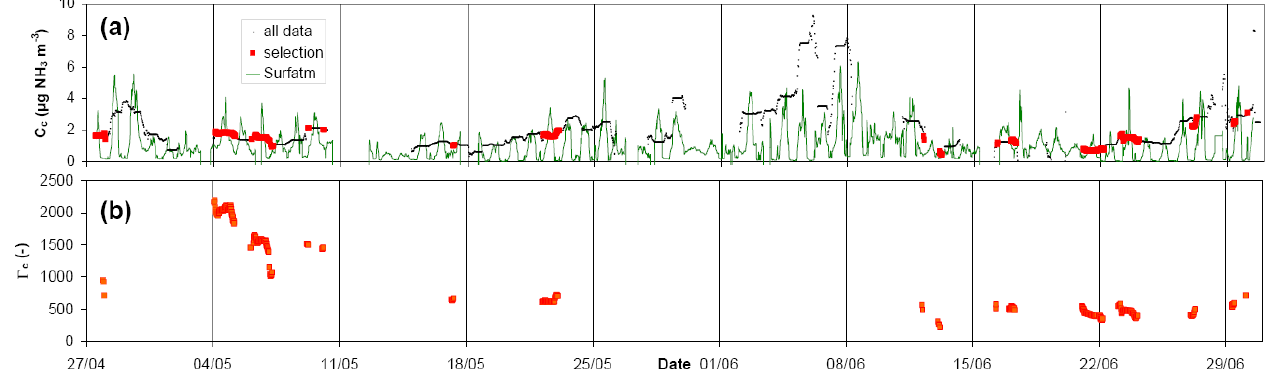
Fig. 8. (a) Canopy compensation point ( C c ) estimated as the offset of the linear regression between the NH 3 flux and NH3 concentration over daily periods (black dots). The selection (red dots) represents periods for which the flux was positive and negative over the day and in which the linear regression had an R 2 > 0.5. The green line is the canopy compensation point estimated as C c = F NH3 × ( R a + R bNH3 ) + C a . (b) Canopy emission potential estimated as Γ c = C c / 10 -3.4362 + 0.0508 Ta(°C) , which can be viewed as the canopy compensation point normalised by the temperature response of the Henry equilibrium.